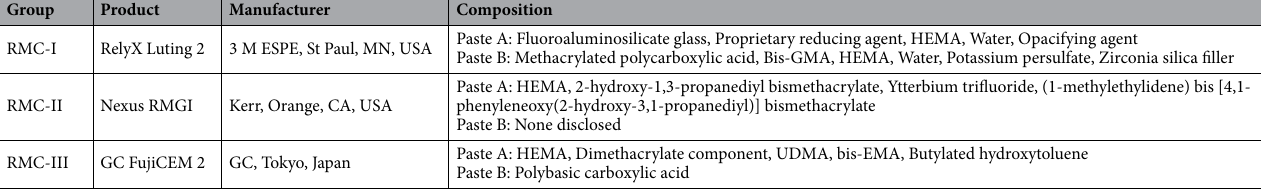
Table 1. Compositions of resin-modified glass ionomer cement (RMGIC) used. Bis-GMA, bisphenol-A- di-glycidylmethacrylate; HEMA, hydroxyethyl methacrylate; TEGDMA, triethylene